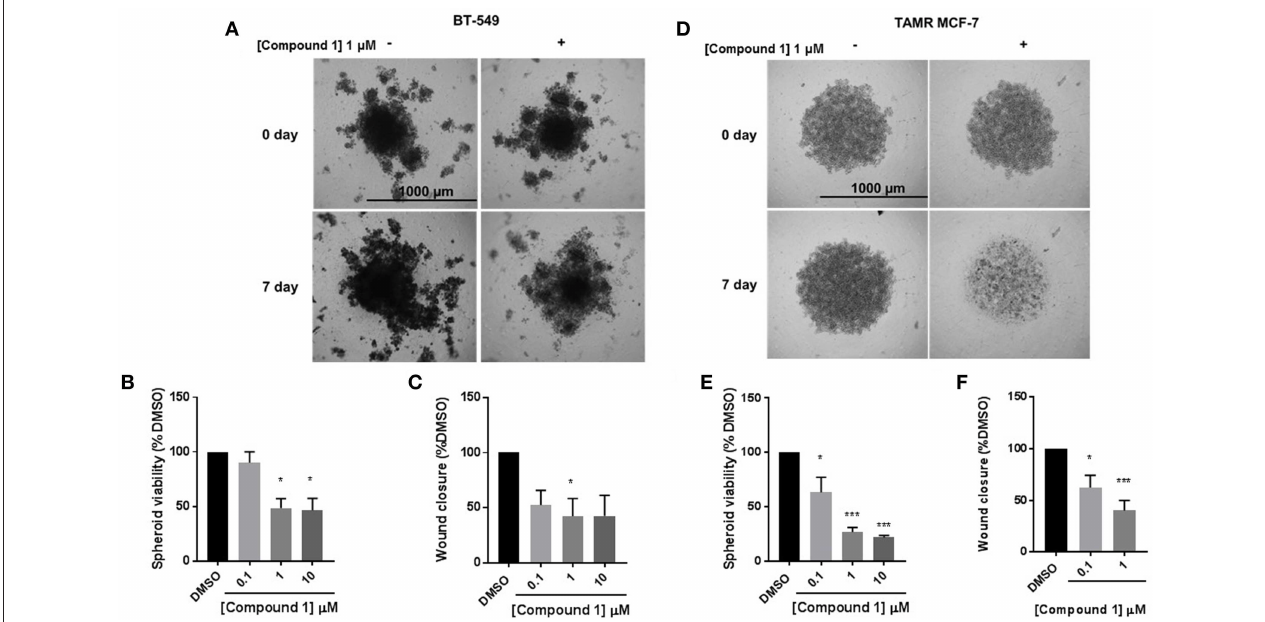
FIGURE 5 | Compound 1 inhibits spheroid viability and cell migration in BT-549 and TAMR MCF-7 cells. (A) Spheroid formation in BT-549 cells after treatment with DMSO or compound 1 at 1 µ M concentration for 7 days, scale bar 1,000 µ m. (B) Quantification of the spheroid viability in BT-549 cells after treatment with compound 1 at increasing concentrations (0.1, 1, 10 µ M) after 7 days of treatment, data represents ± SEM * p < 0.05; *** p < 0.001 vs. control group determined by one-way ANOVA with the Bonferroni post hoc test in BT-549 cells. (C) Wound closure was measured after treatment with increasing concentrations (0.1, 1, 10 µ M) of compound 1 . The data is presented as a percentage of untreated DMSO control group. * p < 0.05 vs. control group determined by one-way ANOVA with the Bonferroni post hoc test (BT-549 cells). (D) Spheroid formation in TAMR MCF-7 after treatment with DMSO or compound 1 at 1 µ M concentration for 7 days, cells scale bar 1,000 µ m. (E) Quantification of the spheroid viability after treatment with compound 1 at increasing concentrations (0.1, 1, 10 µ M) after 7 days of treatment in TAMR MCF-7 cells, values indicate ± SEM of three experiments run in triplicate. * p < 0.05 vs. control group determined by one-way ANOVA with the Bonferroni post hoc test in TAMR MCF-7 cells. (F) Wound closure was measured after treatment with increasing concentrations (0.1, 1, 10 µ M) of compound 1 . The data is presented as a percentage of untreated DMSO control group. * p < 0.05; *** p < 0.001 vs. control group determined by one-way ANOVA with the Bonferroni post hoc test (TAMR MCF-7